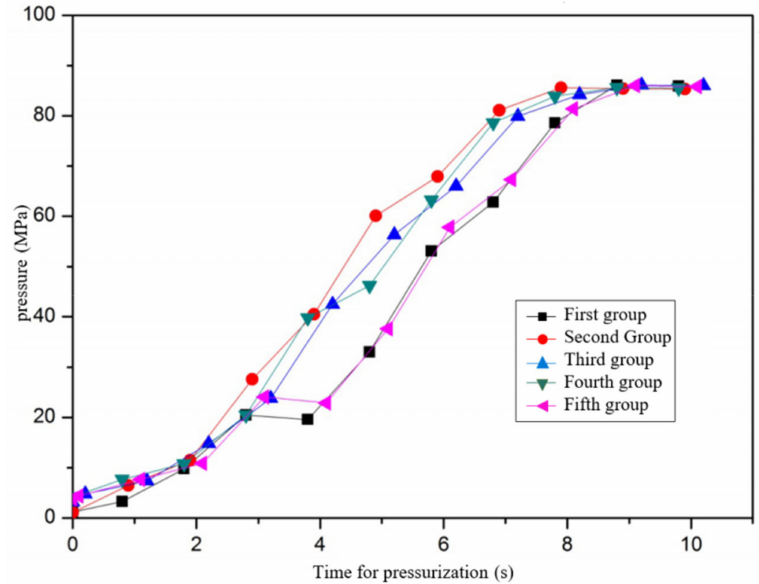
Figure 22. Pressure time curve of four hose